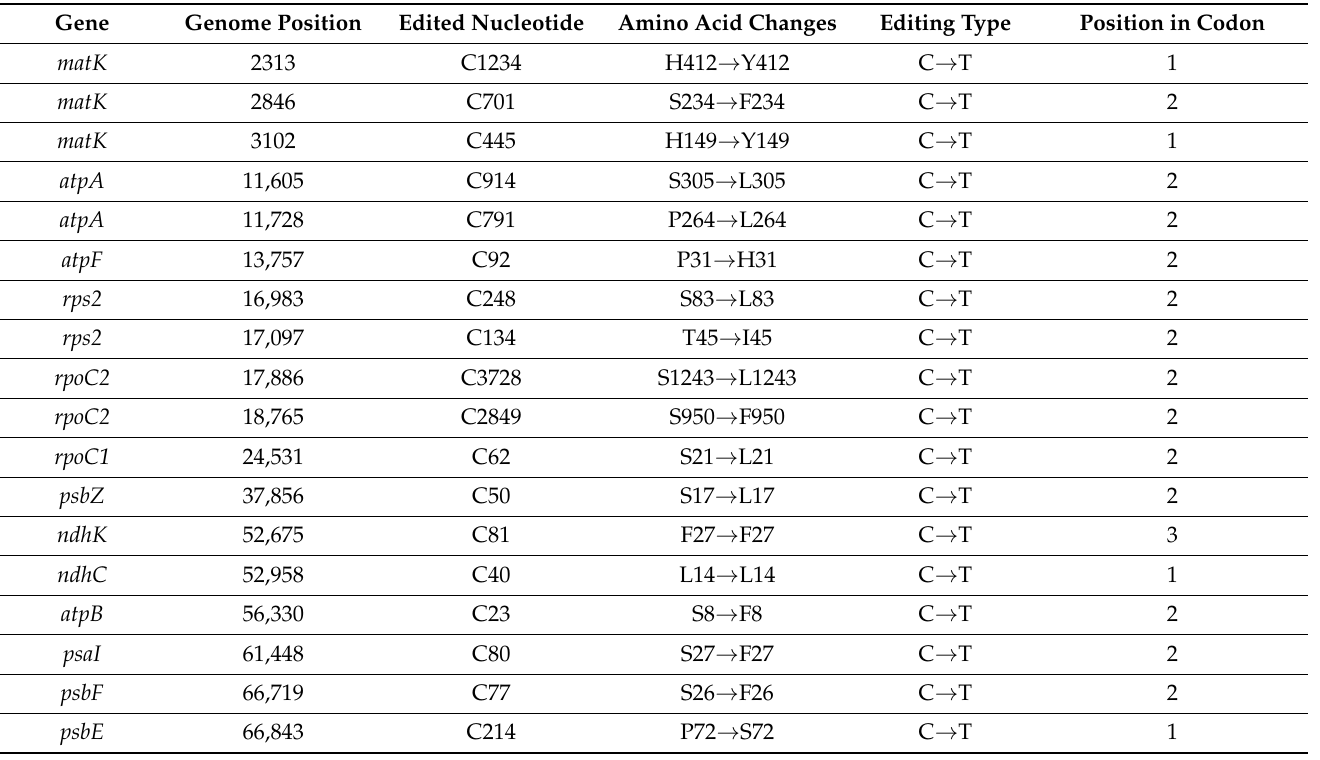
Table 1. RNA editing sites in tea